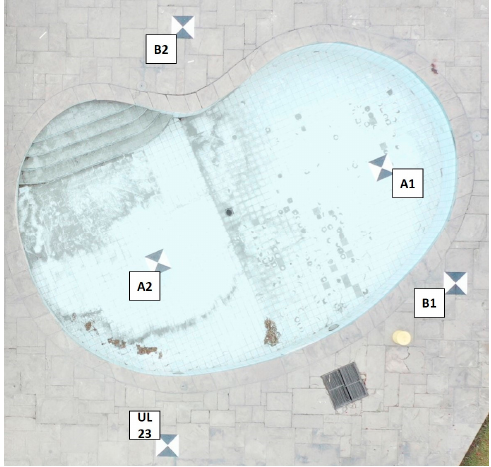
Figure 2. Ground control points (GCPs) in the study area. A1, A2, B1, B2 and UL23 are the names of the control points. pool step used as a reference in the error calculations. Table 3. Control points coordinates.